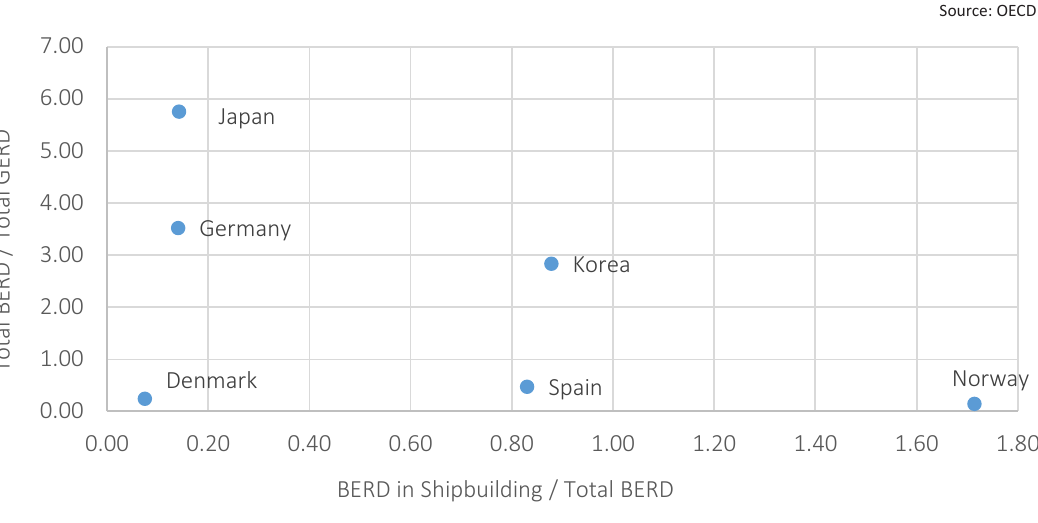
Figure 3. R&D expenditure in the building of ships as a share of total BERD, 2009–2017